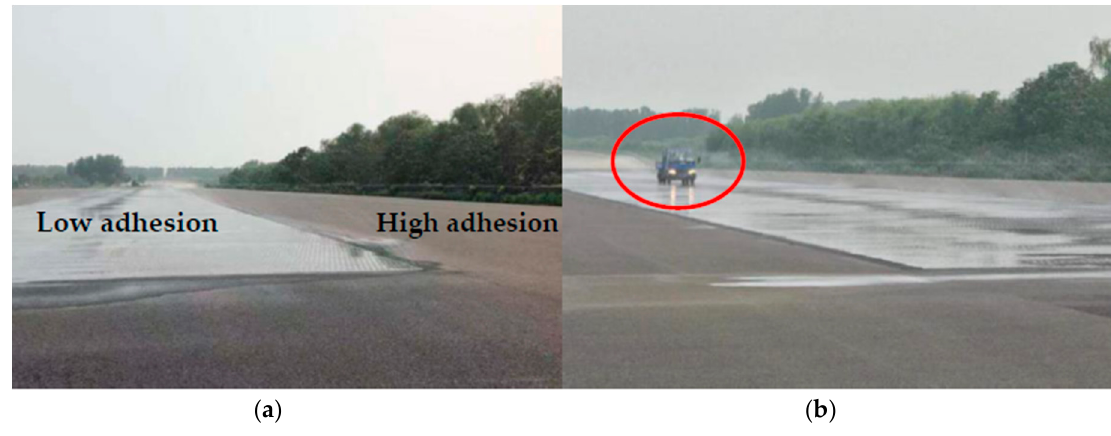
Figure 20. ( a ) Standard test pavement; ( b ) actual road test.